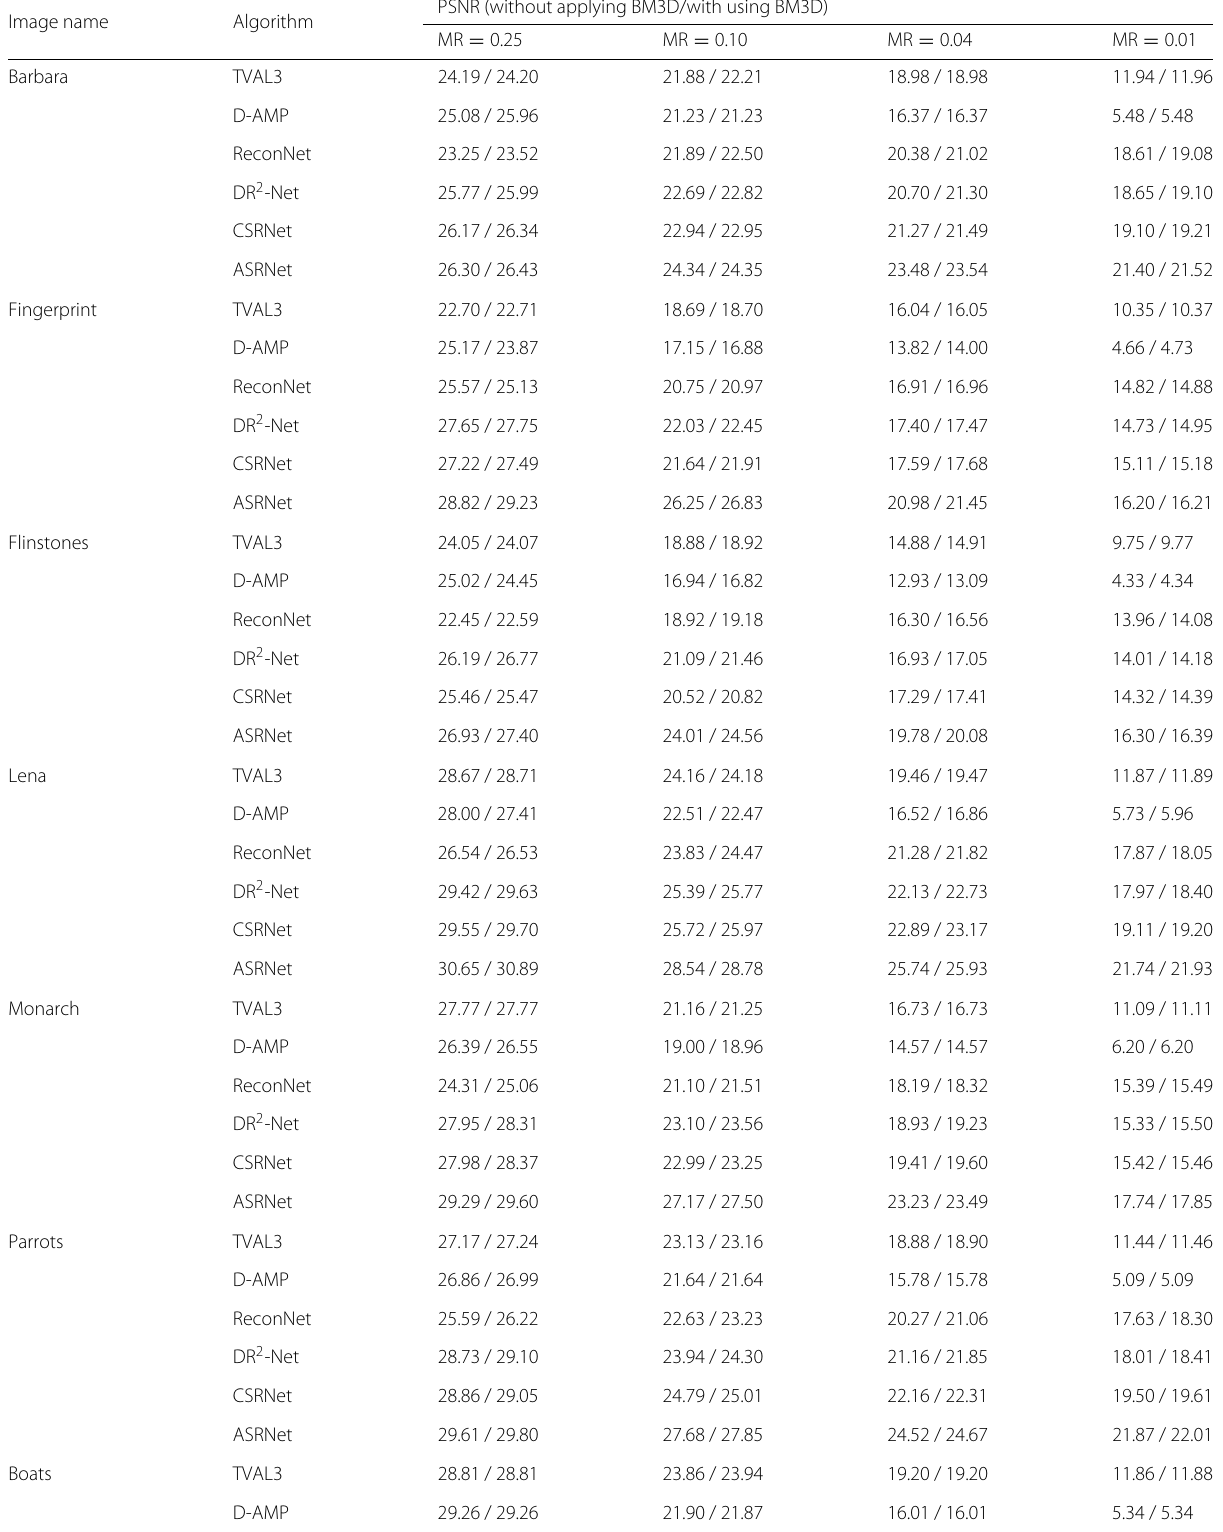
Table 1 PSNR valves in dB for testing image by different algorithms at the ratio MR = 0.25, 0.1, 0.04, and